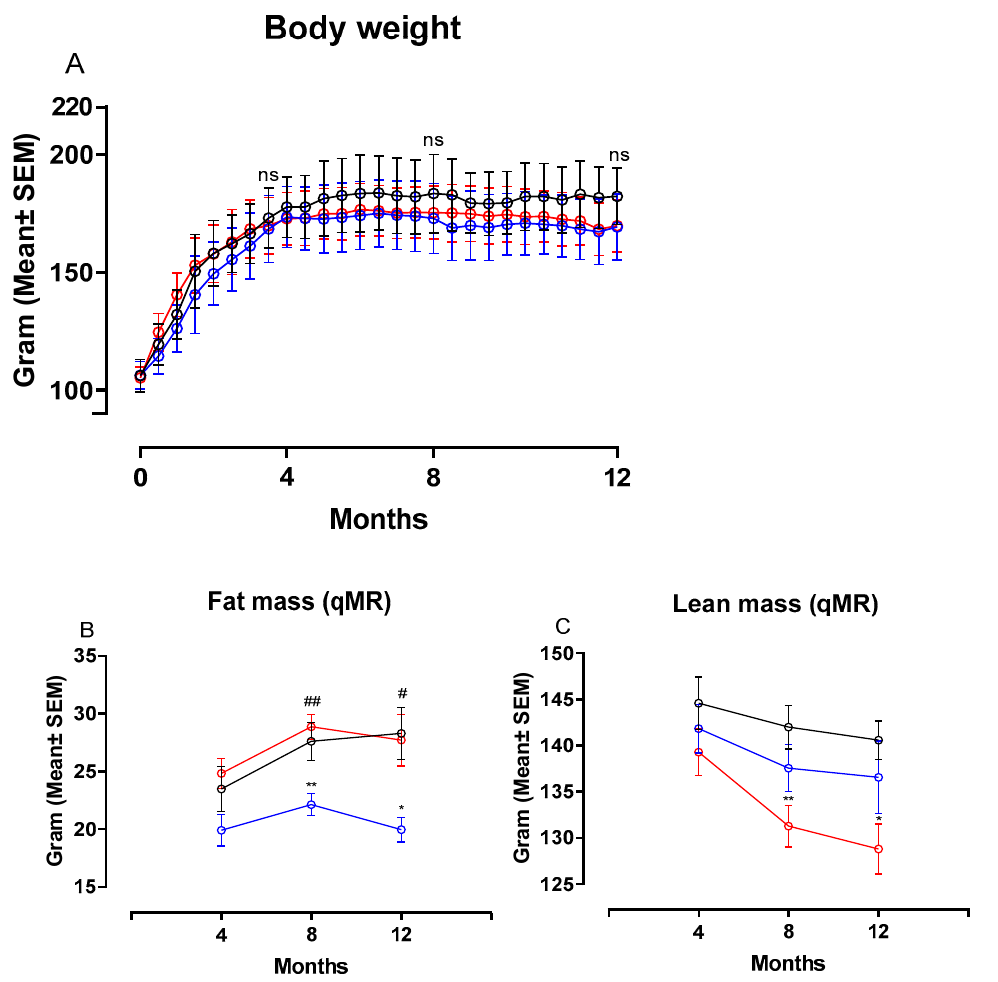
Figure 2. Body weight and body composition after exposure to the NASH and the two control diets. Development in ( A ) body weight, ( B ) fat mass and ( C ) lean mass during the course of the study. Black circles and lines indicate data from chow-fed hamsters. Blue circles and lines indicate data from CTRL-fed hamsters. Red circles and lines indicate data from NASH-fed hamsters. Body weight mean in the three groups are based on group sizes of n = 30 from study initiation to four months, n = 20 from four to eight months and n = 10 from eight to 12 months. Fat and lean mass mean values are based on n = 20 at the four- and eight-month time point and n = 10 at the 12-month time point. * and ** indicate p < 0.05 and p < 0.01 compared to chow. # and ## indicate p < 0.05 and p < 0.01 compared to CTRL. qMR: Quantitative magnetic